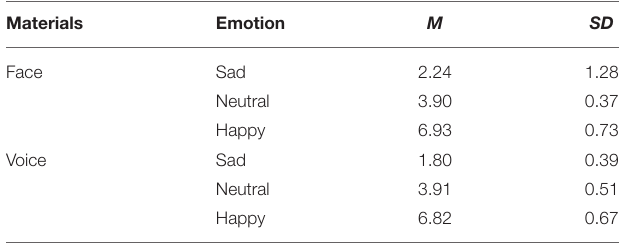
TABLE 1 | Mean evaluation scores for the selected experimental materials.